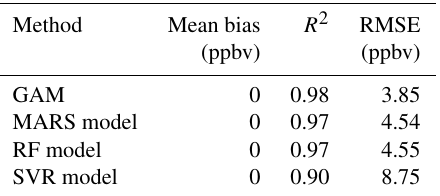
Table 4. Summary of statistical results of the fourth MDA8 ozone predictions after applying the two-step method using four methods at the Crestline